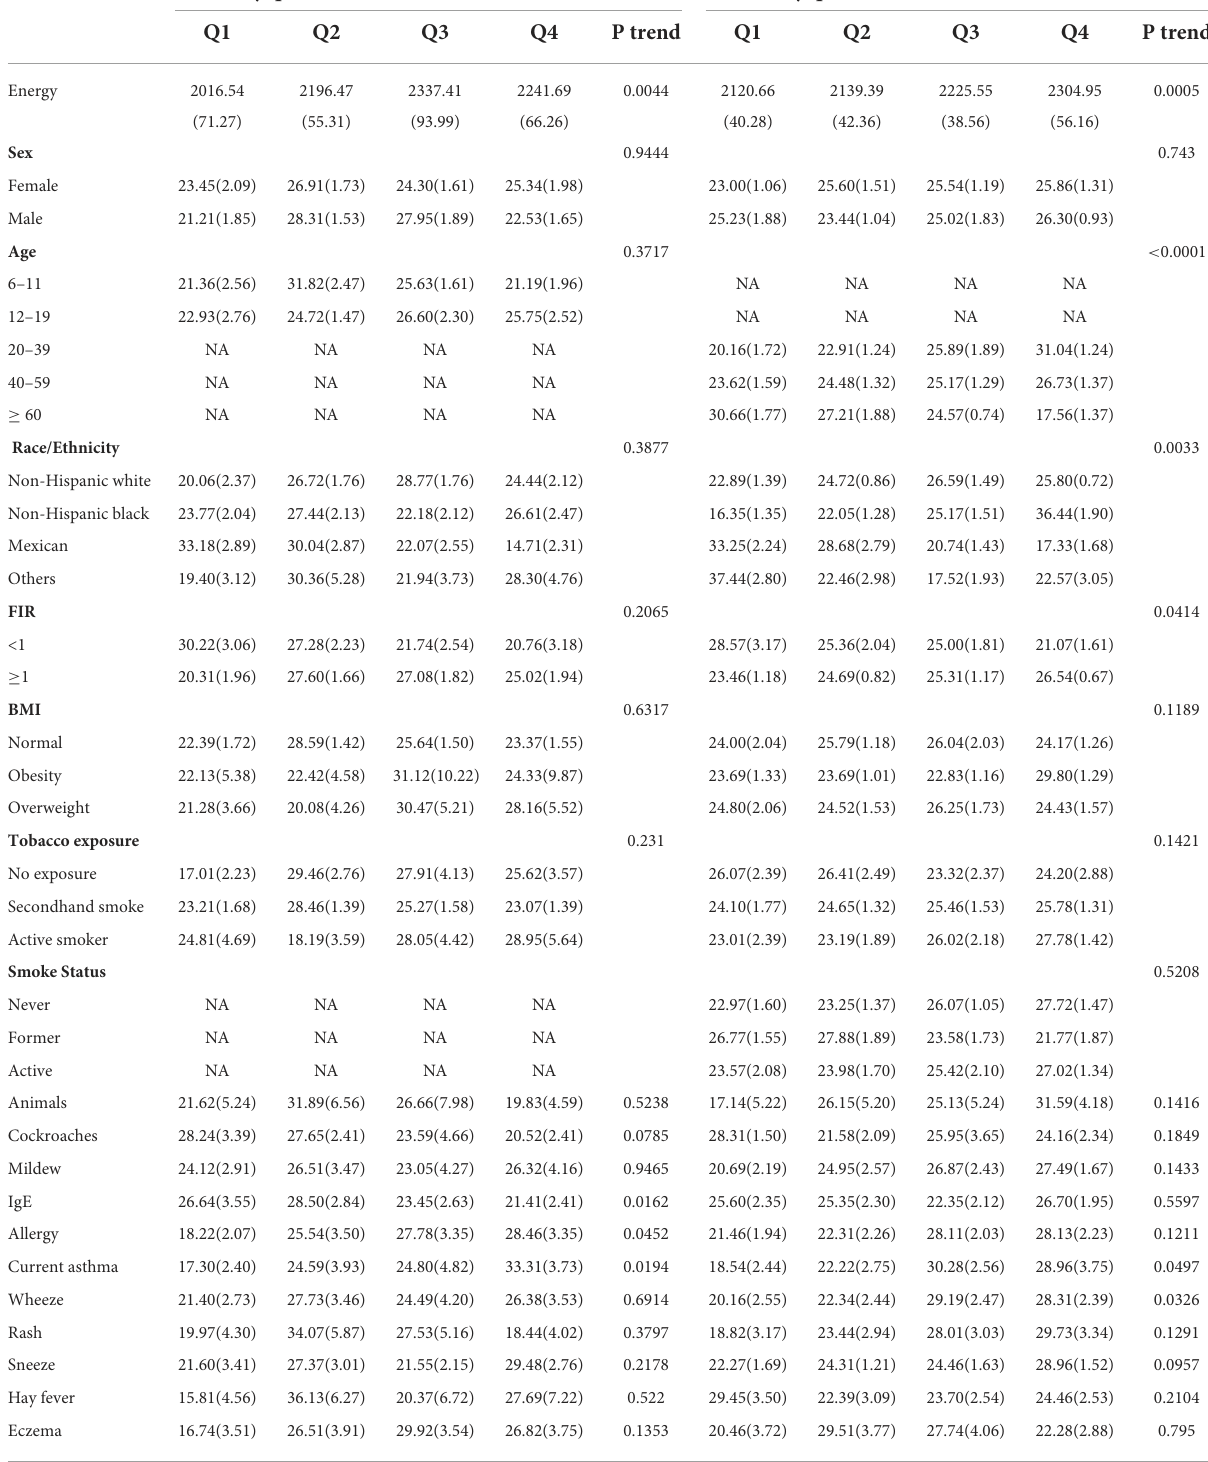
TABLE 1 Characteristics of the study participants according to the quartiles of UPFs (%Kcal) among children and adults.